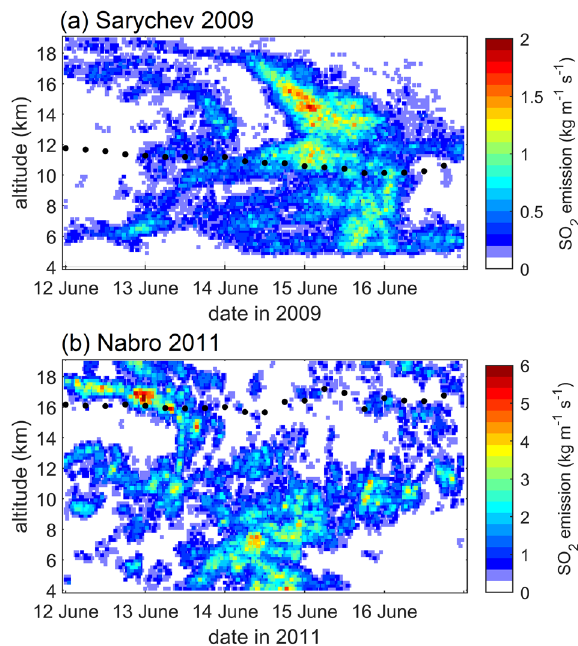
Fig. 1 SO 2 emission time series of two volcanic eruptions. a SO 2 emission time series of Sarychev eruption (2009) and b SO 2 emission time series of Nabro eruption (2011) (unit: kg m − 1 s − 1 ) derived from AIRS measurements using a backward trajectory approach (see texts in the Method section for details). The bin size is 15 min × 0.2 km. Black dots indicate the height of the tropopauses (based on the ERA5 reanalysis). Note that different color bar ranges are used in ( a , b ).